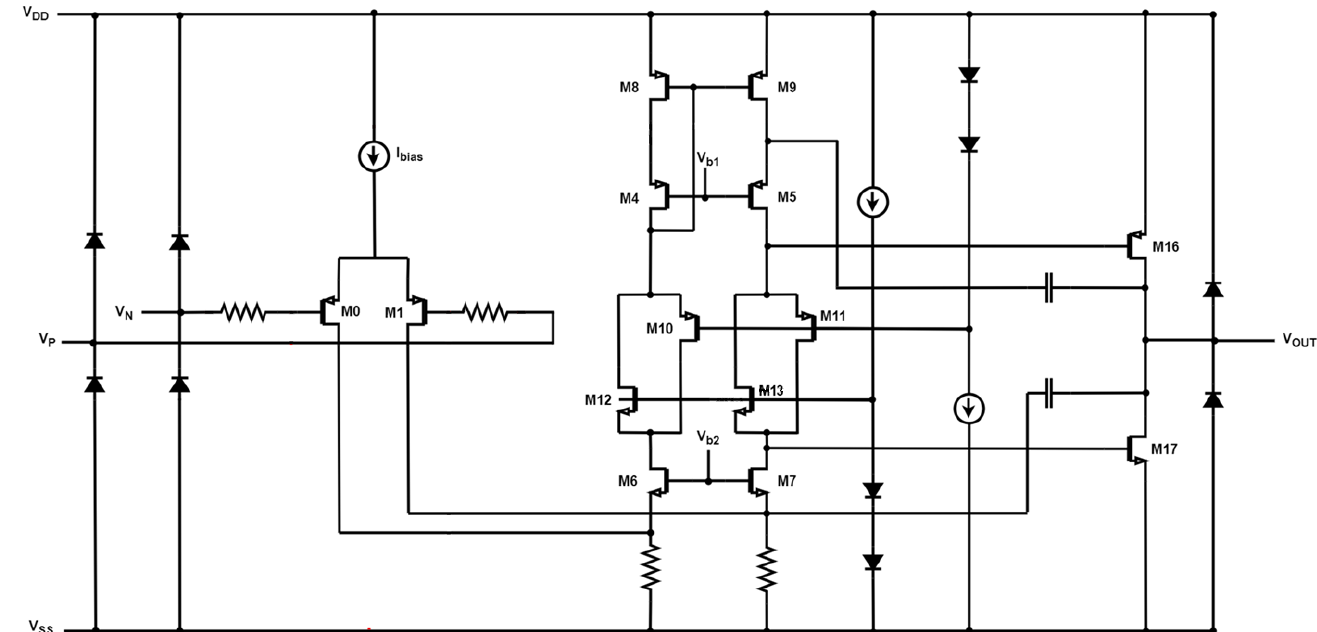
Figure 21. Op-amp schematic for the preamplification stage.